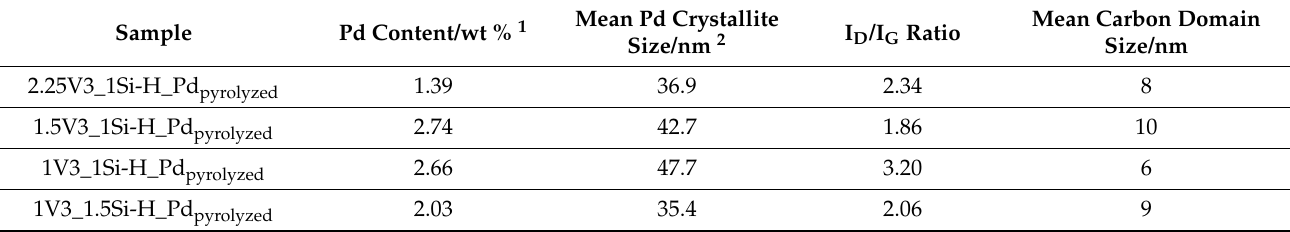
Table 3. Pd contents and mean crystallite sizes in the pyrolyzed samples, ratios of integral intensity of the D (I D ) and G (I G ) bands in the Raman spectra and carbon domain sizes in the Pd-containing pyrolyzed samples calculated based on Raman spectra of the pyrolyzed samples.